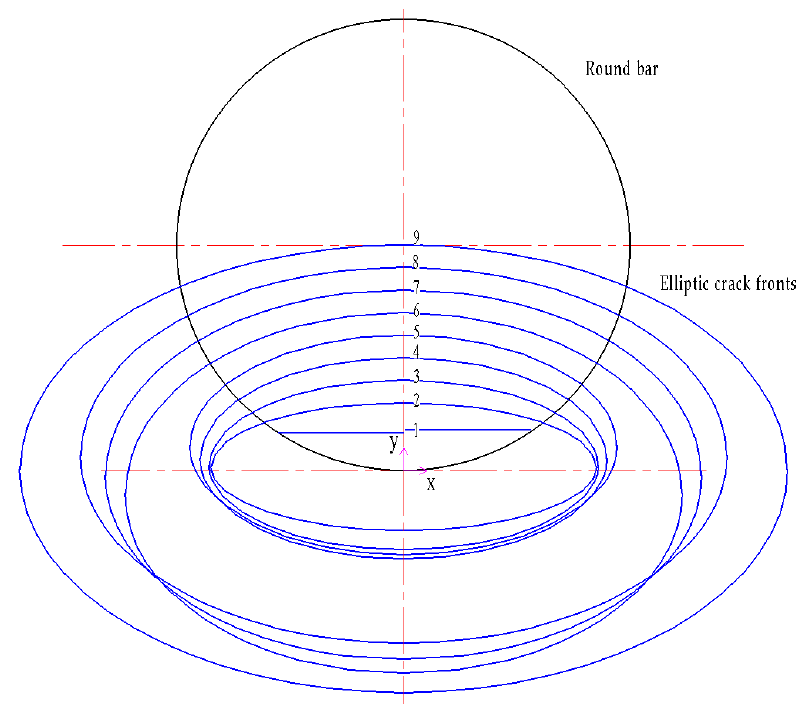
Figure 4. Successive determination of crack fronts by the crack growth circles with initial crack 𝑏 0 𝑎 0 ⁄ = 1,𝑏 0 𝐷 0 = 0.1⁄ , 𝑚 = 2.